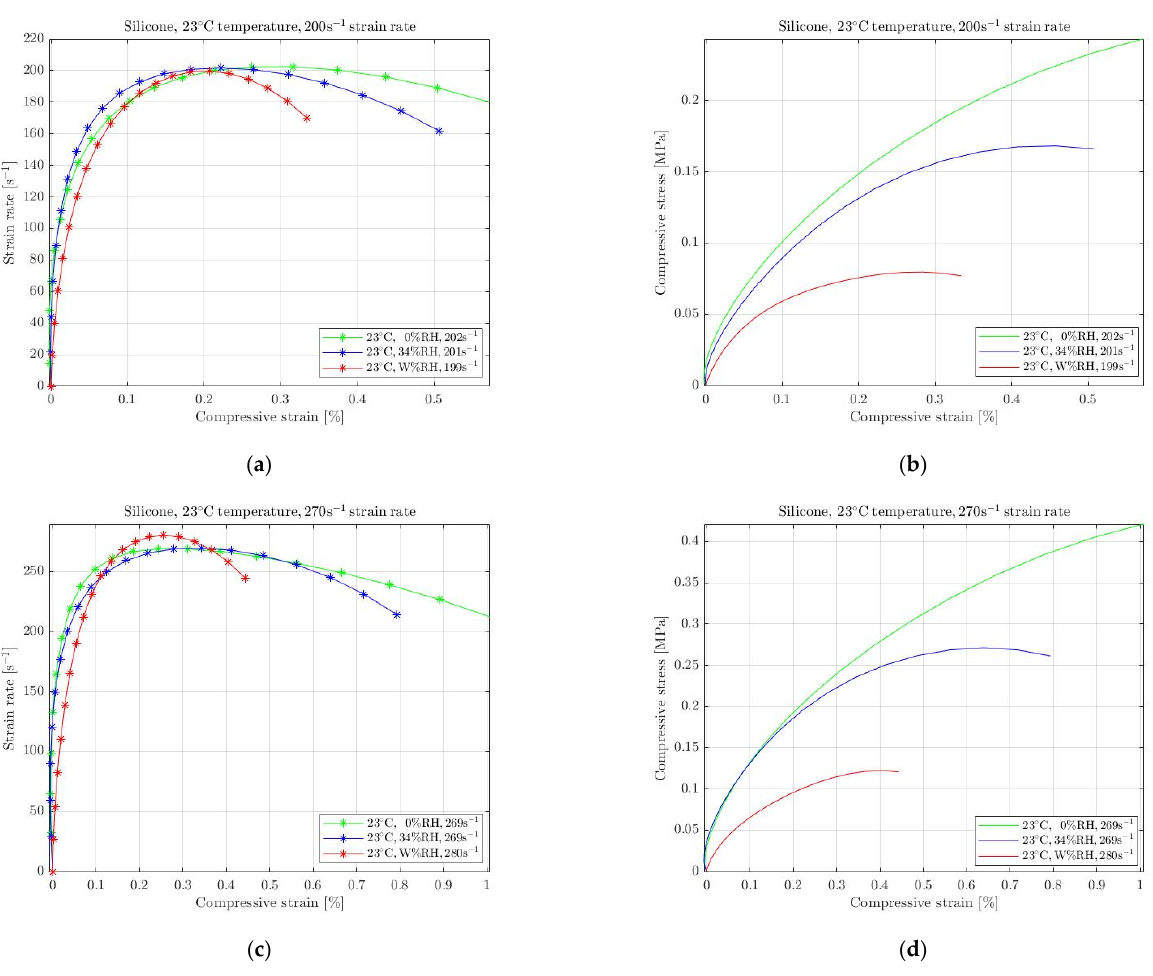
Figure 9. Strain rate vs. compressive strain ( a , c ) and compressive stress vs. compressive strain ( b , d ) of silicone subjected to absolute wet (W% RH) and dry (0% RH) conditions at 23 °C temperature compared with the ambient conditions (34% RH) for 200 s − 1 ( a , b ) and 270 s − 1 ( c , d ) strain rate. For EPDM, the results are presented in Figure 10, where the specimens were subjected to 180 s − 1 (Figure 10a) and 270 s − 1 (Figure 10d) strain rates. Regulating moisture from the ambient environment affected EPDM as well, with the required stress to be increased and decreased when exposed to absolute dry and wet conditions, respectively.